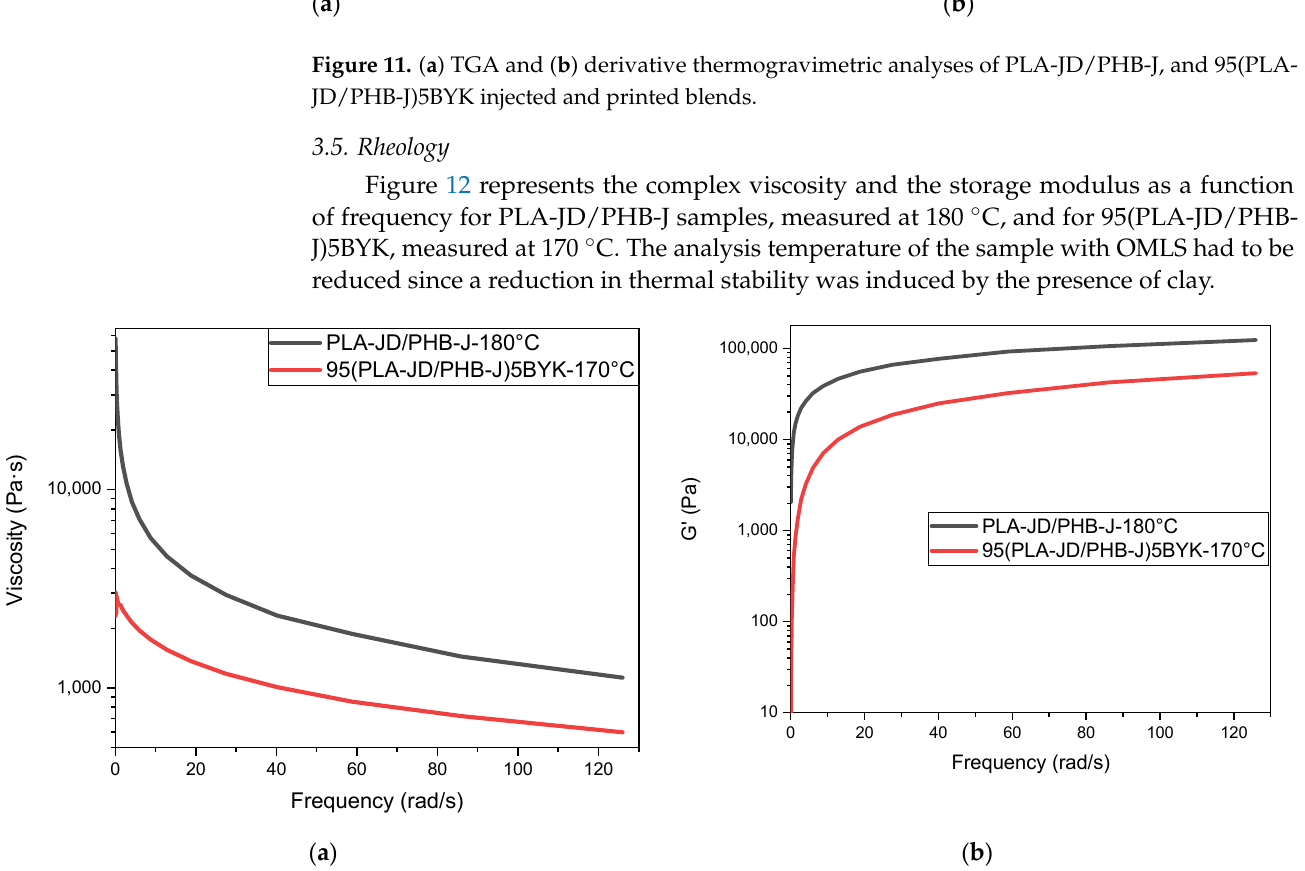
Figure 11. ( a ) TGA and ( b ) derivative thermogravimetric analyses of PLA-JD/PHB-J, and 95(PLA- JD/PHB-J)5BYK injected and printed blends.